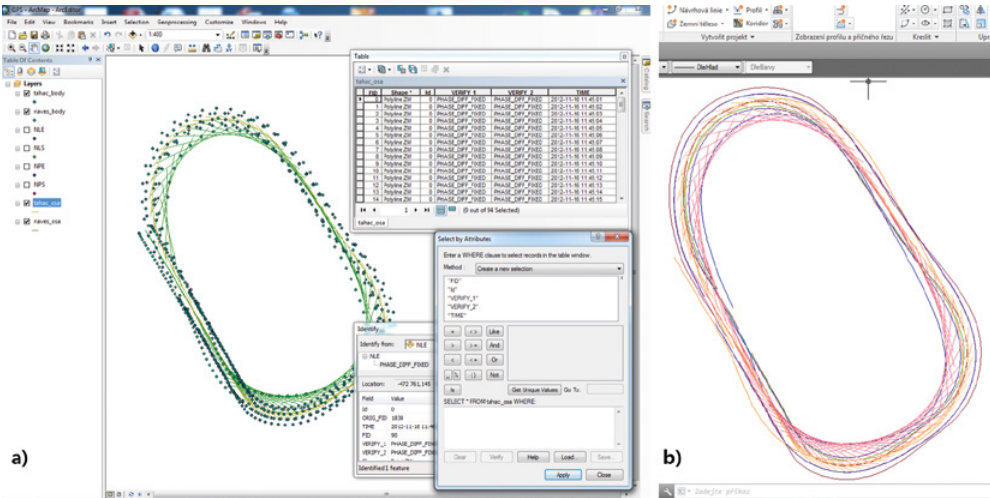
a) example of a part of processed points from Global Navigation Satellite System apparatus Figure 2. Measured points